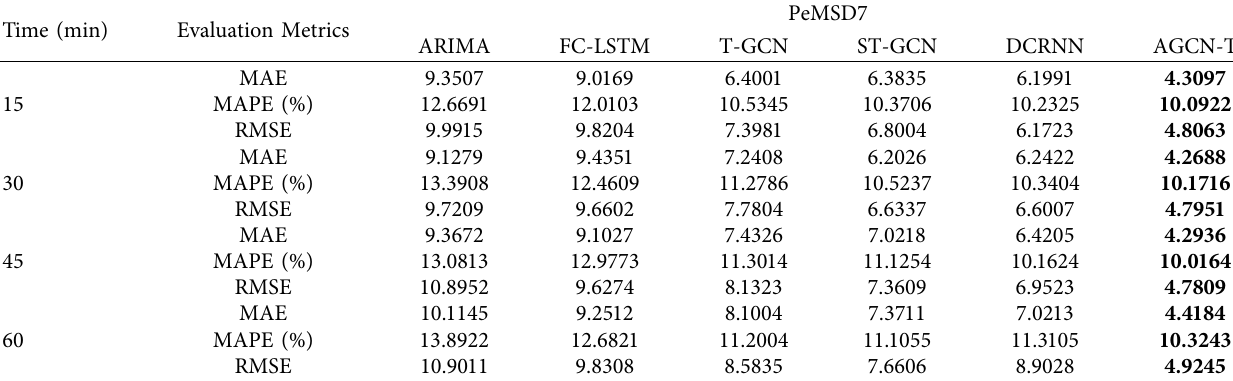
Table 3: Prediction performance of each method on PeMSD7.